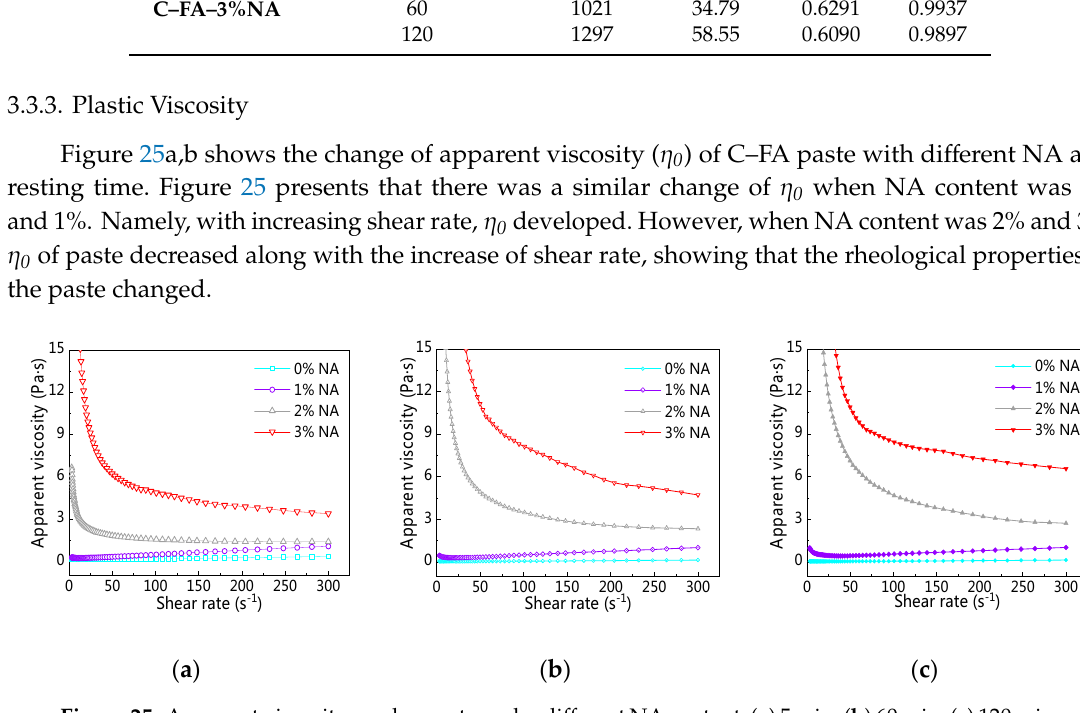
Figure 25. Apparent viscosity vs. shear rate under different NA content. ( a ) 5 min; ( b ) 60 min; ( c ) 120 min.